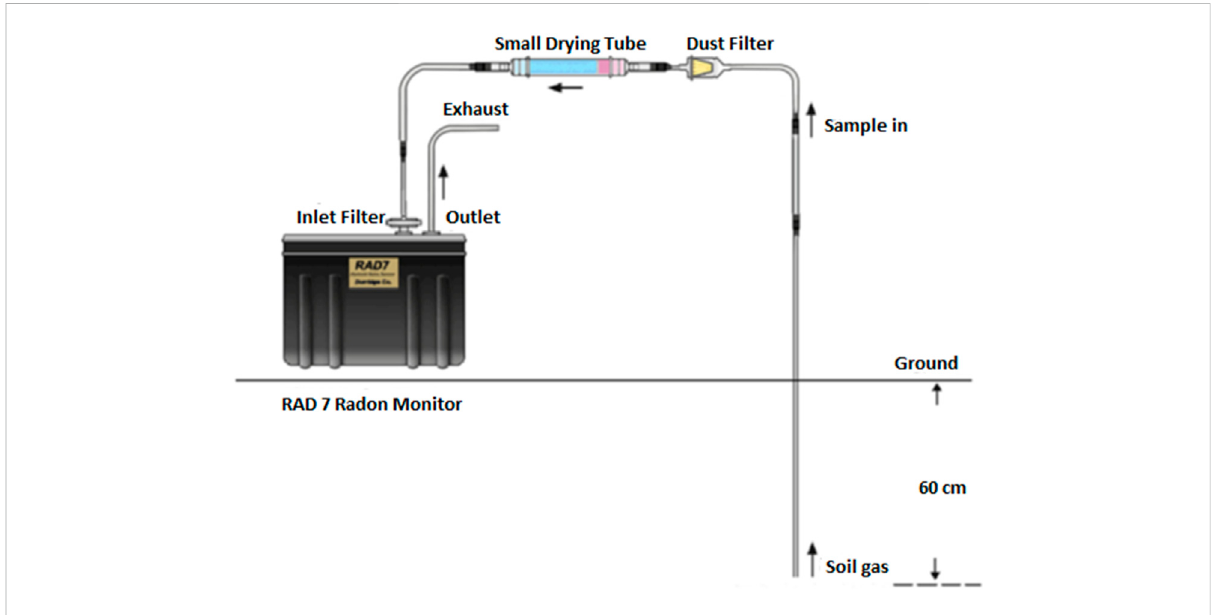
FIGURE 2 Measurement procedure for radon in soil (Liu et al.,